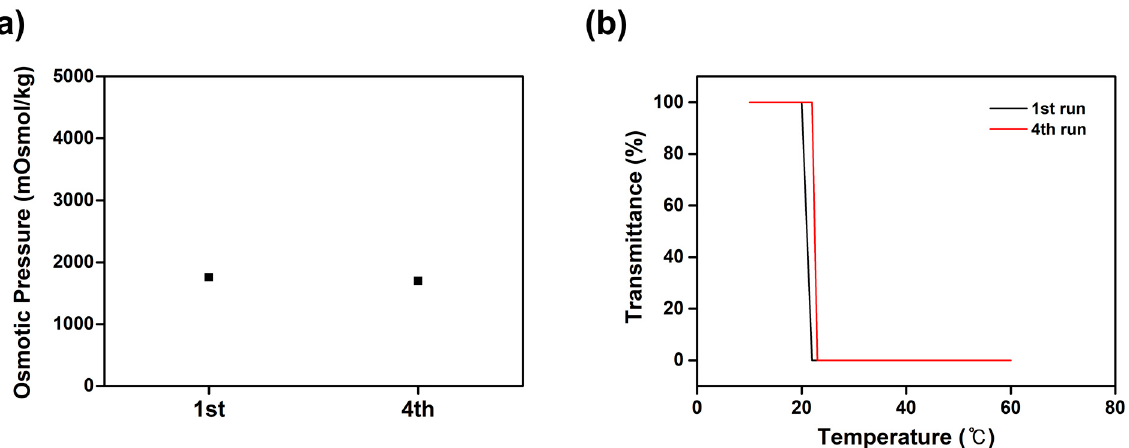
Figure 9. Recyclability study of [(P 4444 ) 2 ][MBS] in four cycles: ( a ) osmotic pressures and ( b ) thermoresponsive behavior tests. From the 2nd to the 4th run, the recovered [(P 4444 ) 2 ][MBS] from the previous run was used.